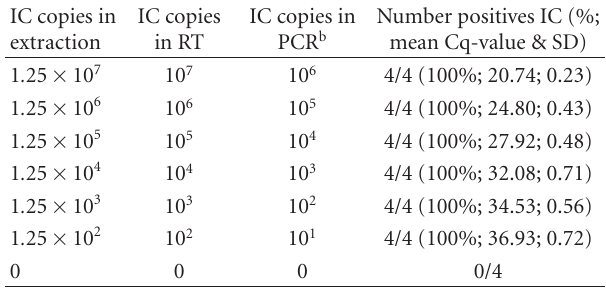
Table 2: Dynamic range of IC a